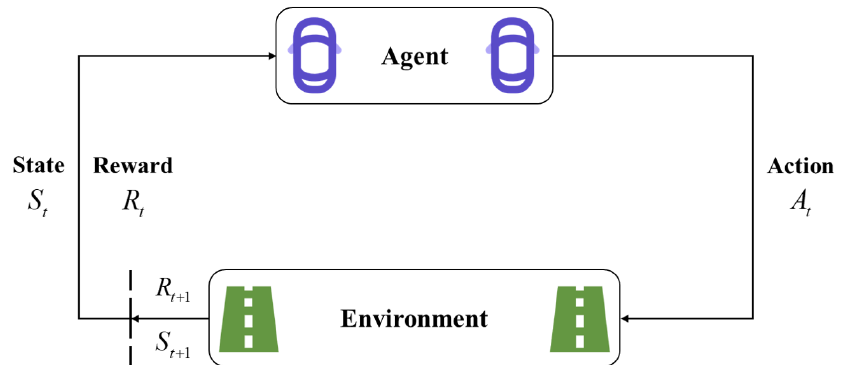
Figure 1. Markov Decision